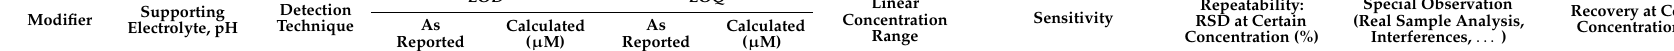
Special Observation (Real Sample Analysis, Interferences, ... )